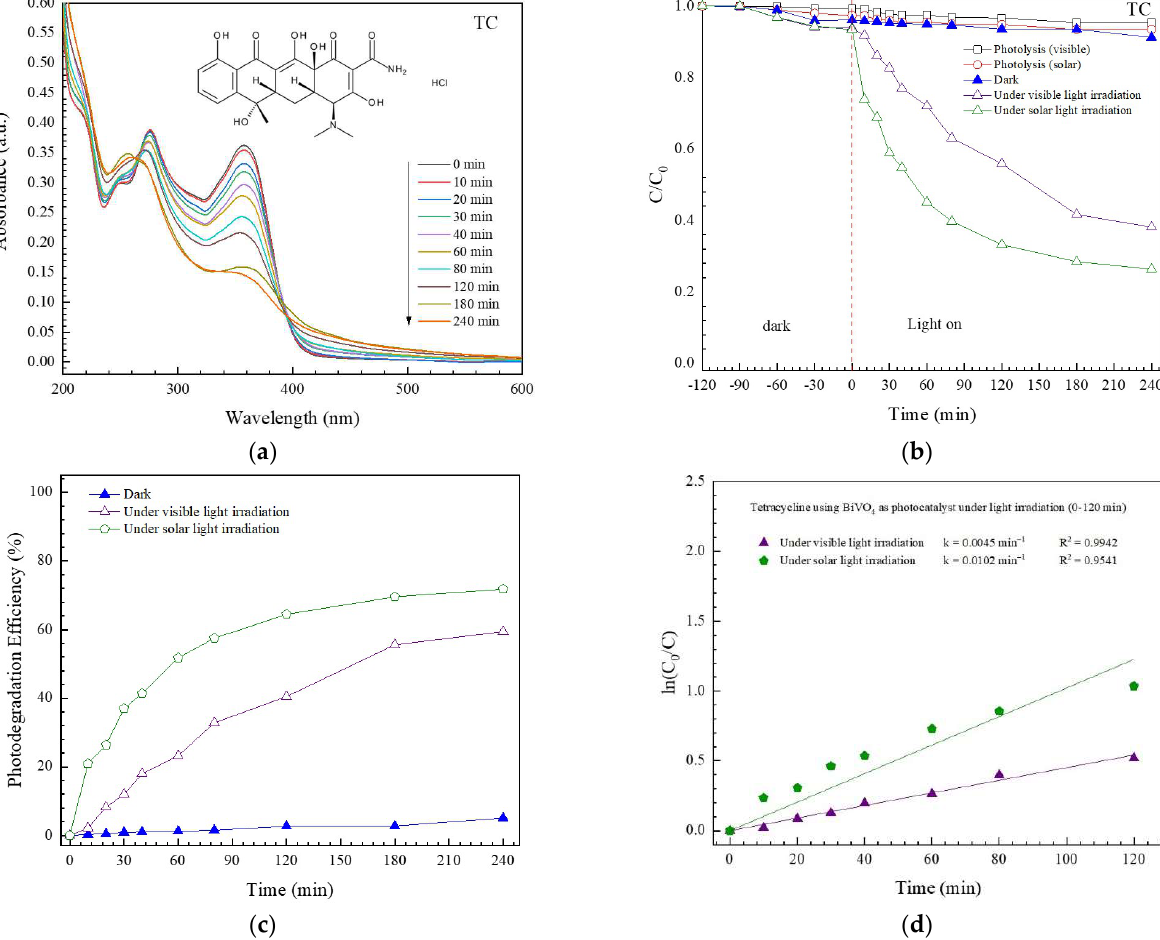
Figure 8. Lowering of absorbance with time toward photodegradation of TC ( a ), a decrease of C/C 0 with time ( b ), photodegradation efficiency ( c ), and determination of rate constant ( d ).